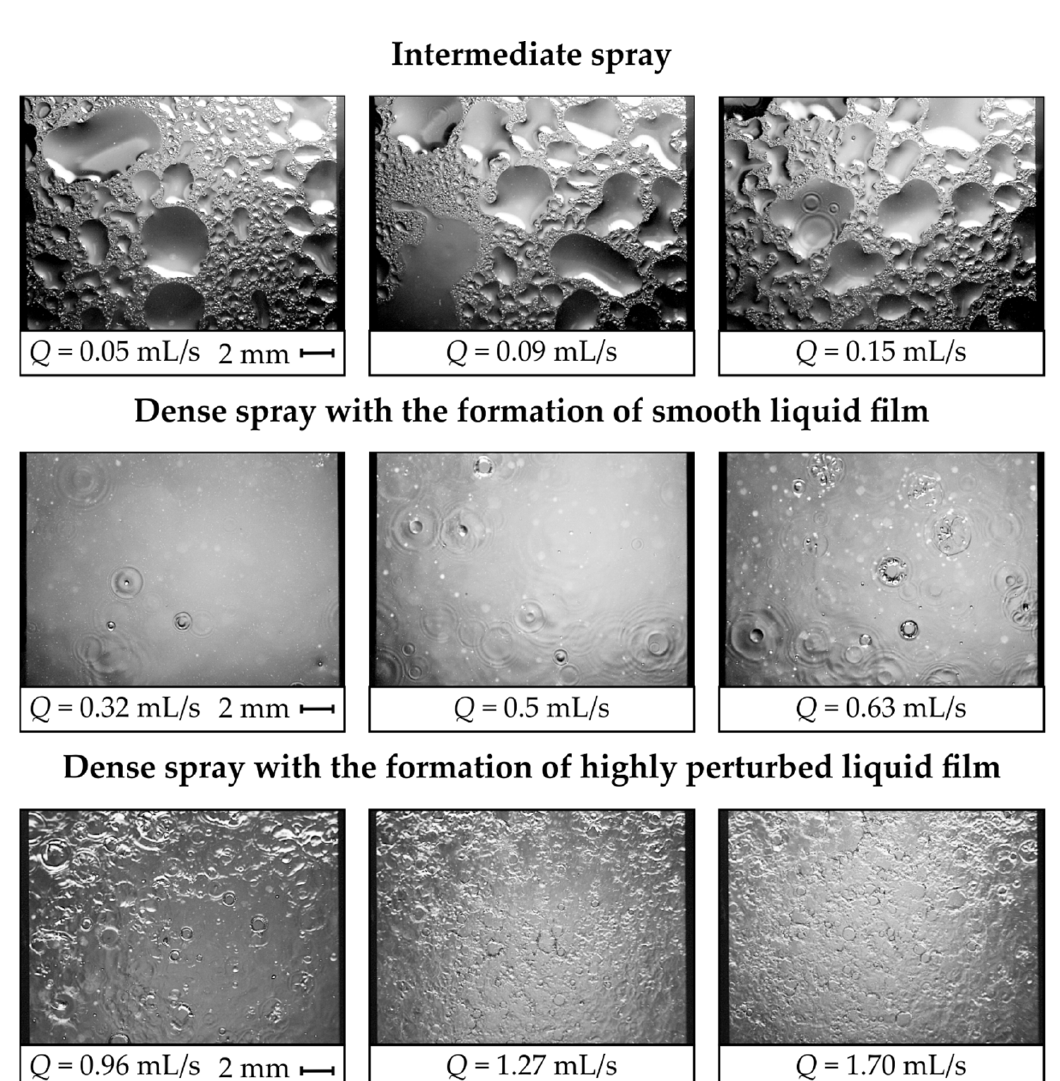
Figure 4. The various patterns during spray irrigation of the transparent impact surface investigated in the paper.